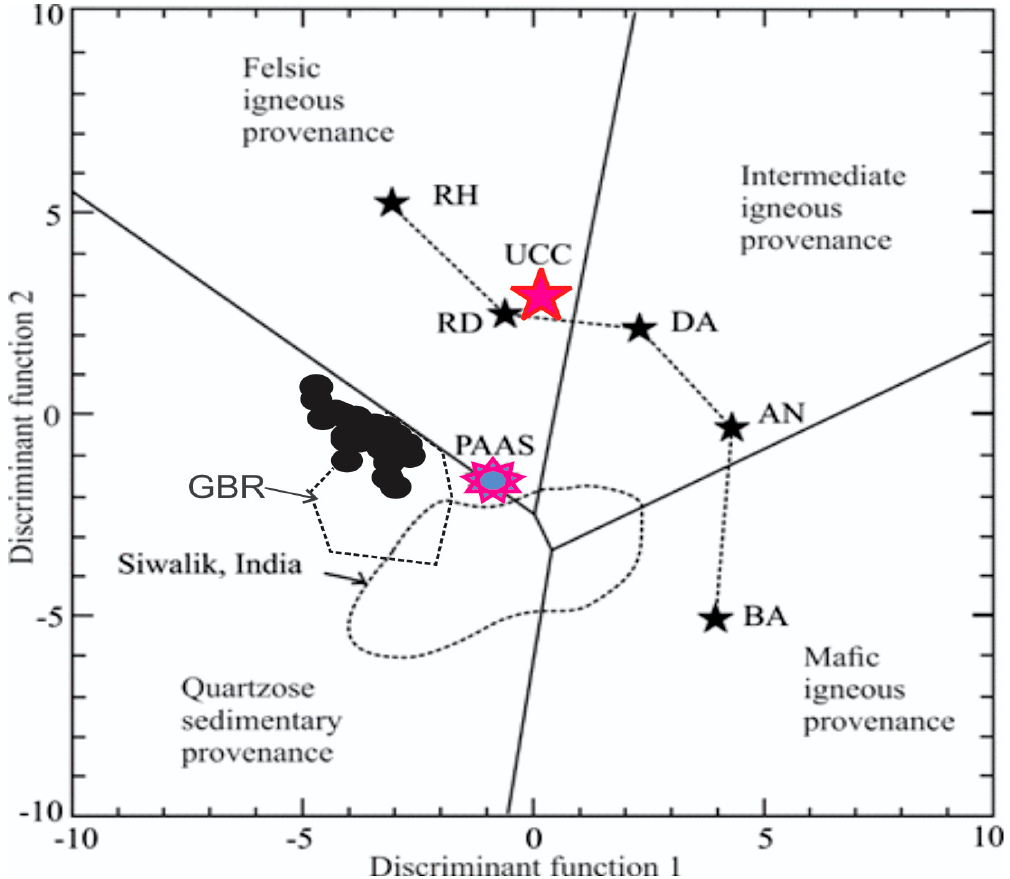
Figure 6. Major element provenance discriminant plot for the Brahmaputra River sediments. Fields for Siwalik Group sediments in NW Himalaya (India) from data in Ranjan and Banerjee [39] and the Ganges ‐ Brahmaputra Rivers (GBR) from Hossain [9]. Stars: BA, AN, DA, RD, RH—average basalt, andesite, dacite, rhyodacite and rhyolite, as plotted by Roser and Korsch [38]. Brahmaputra River sediment samples are represented by the black dots.